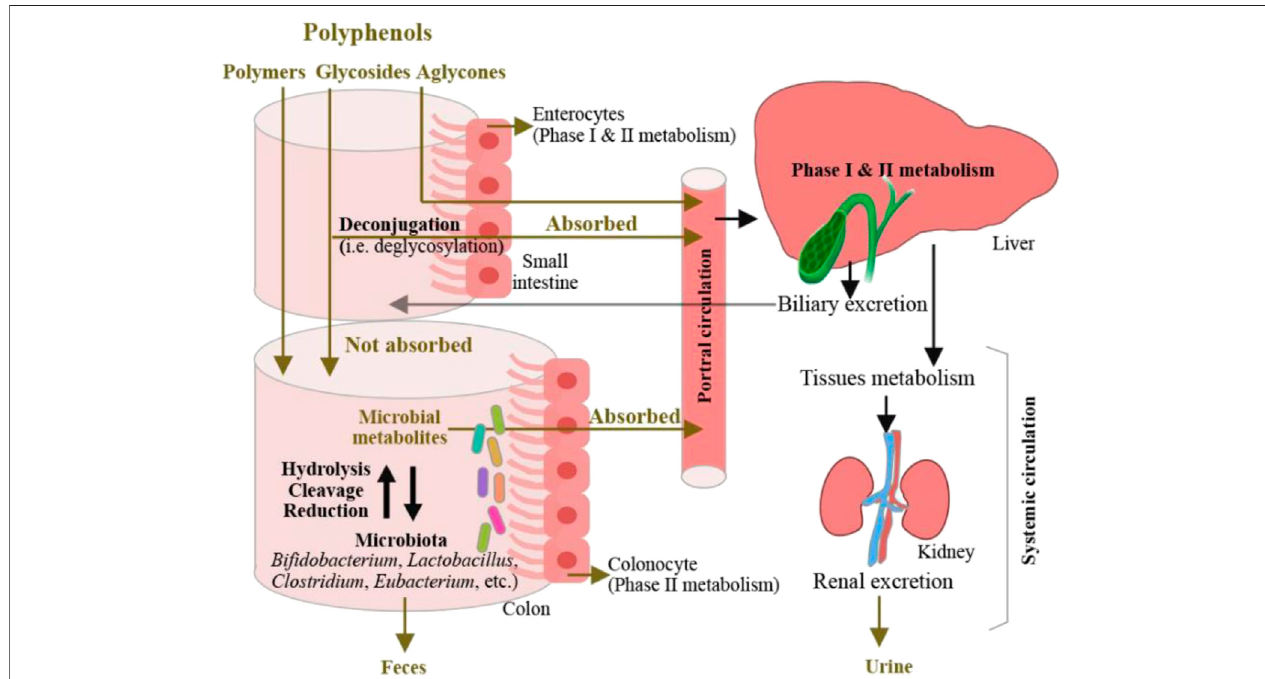
FIGURE 9 | Absorption of dietary polyphenols and their microbial transformation in the intestine. [reproduced with copyright permission from ACS Publications (Liu J. et al., 2020)]